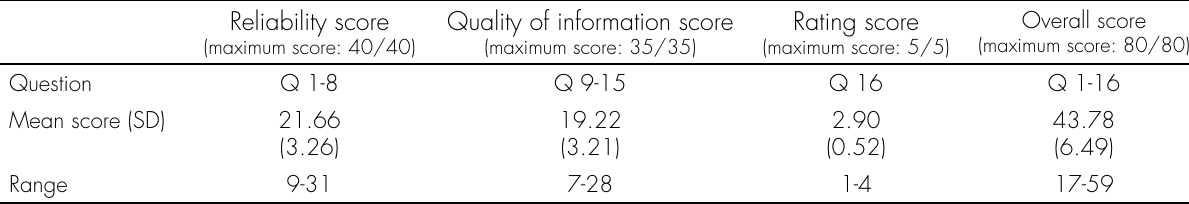
KEY. SD: standard deviation